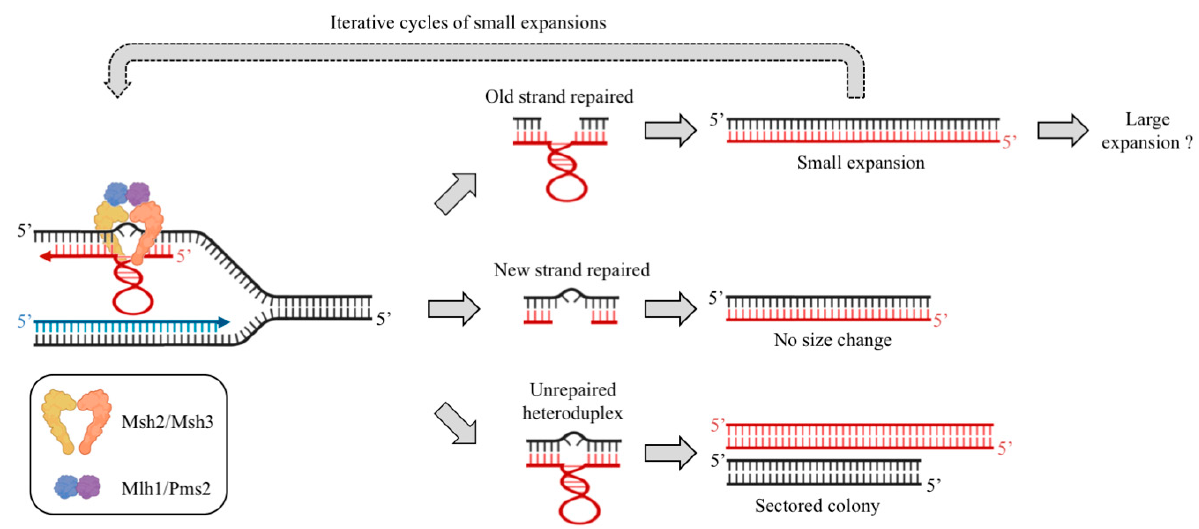
Figure 1. Possible roles of mismatch repair in trinucleotide repeat instability. Slippage during CAG/CTG replication on the newly synthesized lagging strand generates heteroduplex DNA. This mismatch is recognized by the MutS β complex (and to a lesser extent by MutS α ) and by MutL α (and probably other MutL complexes too). If the old strand is fixed using the newly synthesized strand as a template, a small repeat expansion will occur (Top). If the hairpin is removed, and the newly synthesized strand is fixed using the old strand as a template, no size change occurs. (Middle). If the heteroduplex escapes repair by the MMR, segregation of both strands during the following cell cycle will lead to a mixed progeny (sectored colony). Note that several rounds of small expansions may occur during somatic cell divisions. In addition, above a certain length threshold, a large expansion may occur, by a yet unknown mechanism, which may involve DNA repair and/or recombination.